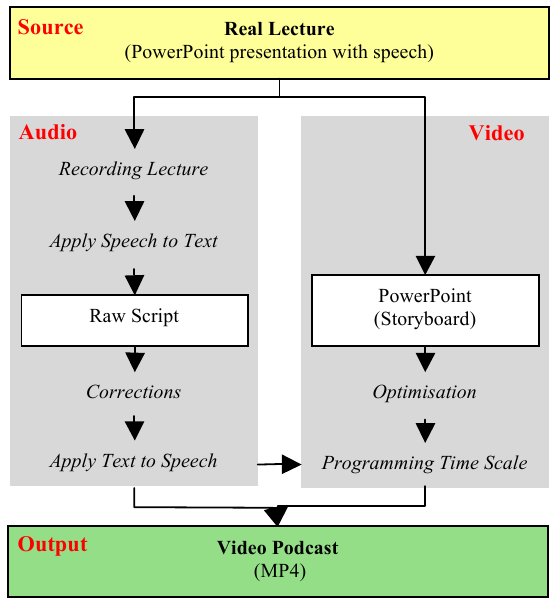
Figure 8: Flowchart of creating video podcasts